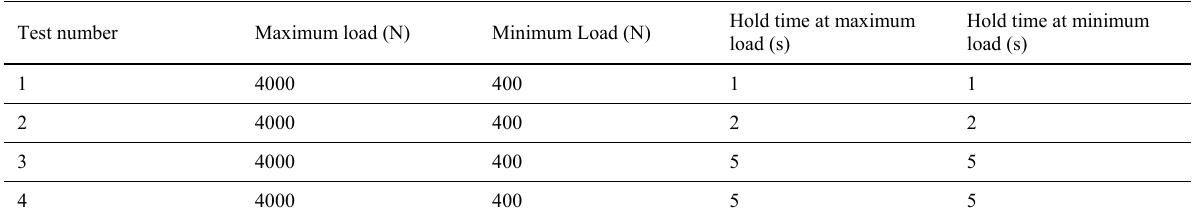
Table 2: Fatigue tests conducted at 40 ⁰ C